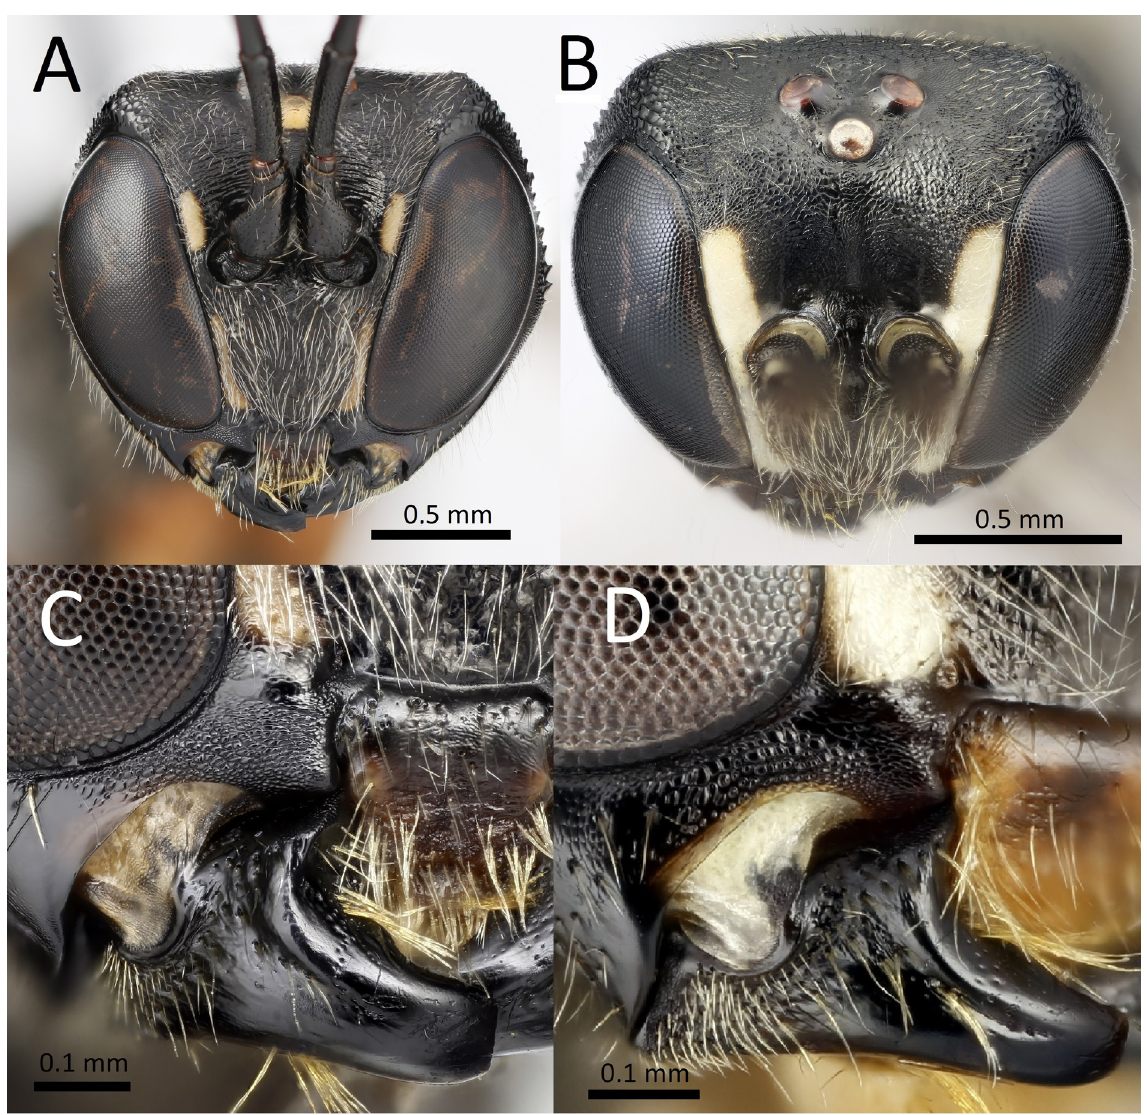
Fig. 7. A . Neoxorides opacus (Kokujev, 1903) stat. rev., ♀ (NJ), head, anterior view. B . N. collaris (Gravenhorst, 1829), ♀ (NJ), head, anterodorsal view. C . N. opacus , ♀ (NJ), mandible, lateral view. D . N. collaris , ♀ (NJ), mandible, lateral view. Photos: Alexander